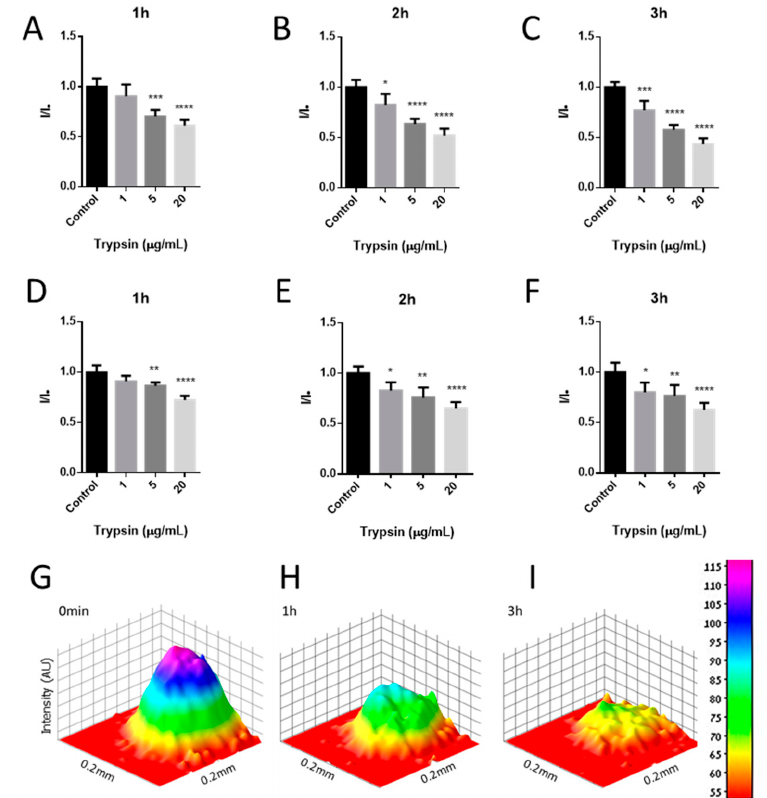
Figure 7. Time- and concentration-dependent changes in HexCoil-Ala-SWCNTs photoluminescence after incubation with trypsin or without trypsin (control); in ( A–C ) phosphate-buffered saline (PBS) or in 8.3% ( D–F ) urine. 3D photoluminescence intensity plot ( G ) immediately after addition, ( H ) 1 h after the addition, and ( I ) 3 h after the addition of 20 µg/mL trypsin. Error bars represent SD. One-way ANOVA, p < 0.05, n = 4. Table 1. A table representation of the relative intensity values ± SD of time- and concentration- dependent changes in HexCoil-Ala-SWCNTs’ photoluminescence after incubation with trypsin in PBS or in 8.3% v/v urine. p < 0.05, n = 4.